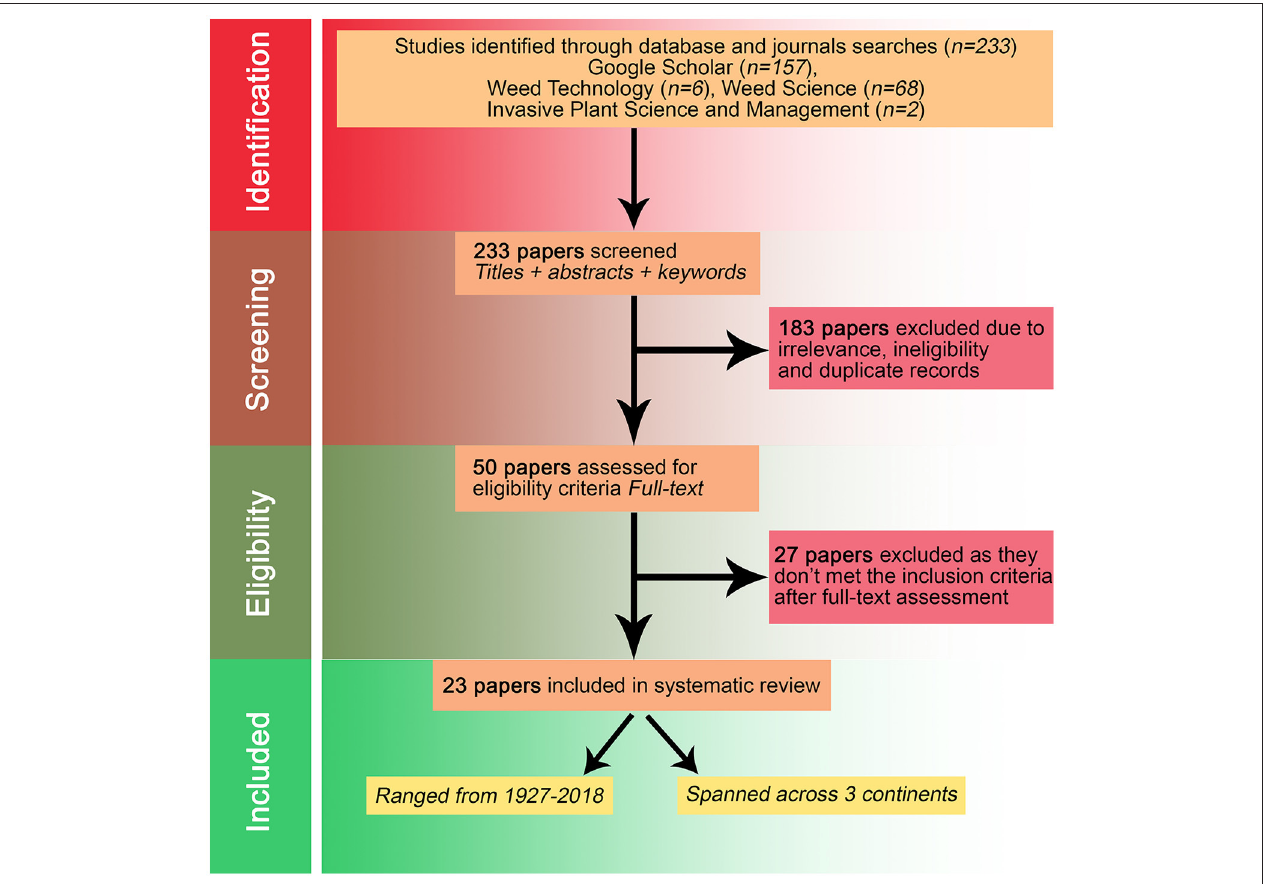
FIGURE 1 | Preferred Reporting Items for Systematic Reviews and Meta-Analyses (PRISMA) diagram outlining the selection procedure for papers reporting the findings of experiments conducted on the water use (WU) of the